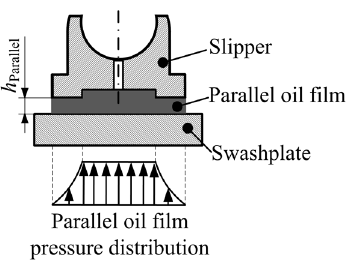
Figure 13. The diagram of parallel oil film between the slipper and swashplate.